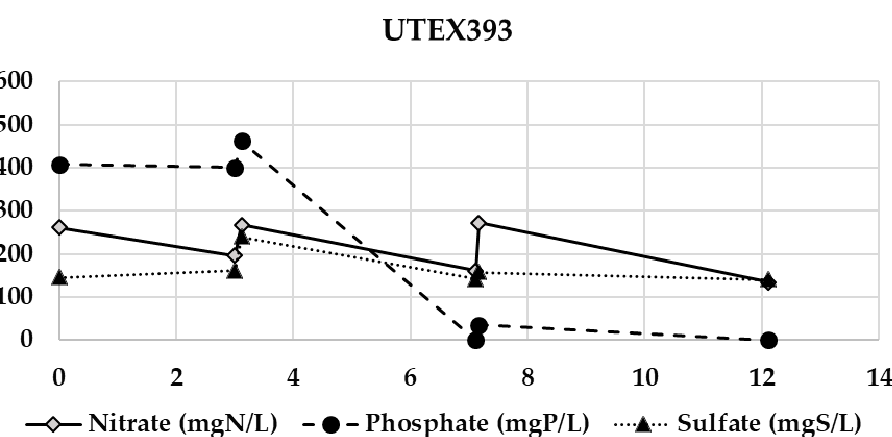
Figure A4. Evolution of the nitrate, phosphate, and sulfate concentrations during the semi-continuous test for UTEX393.